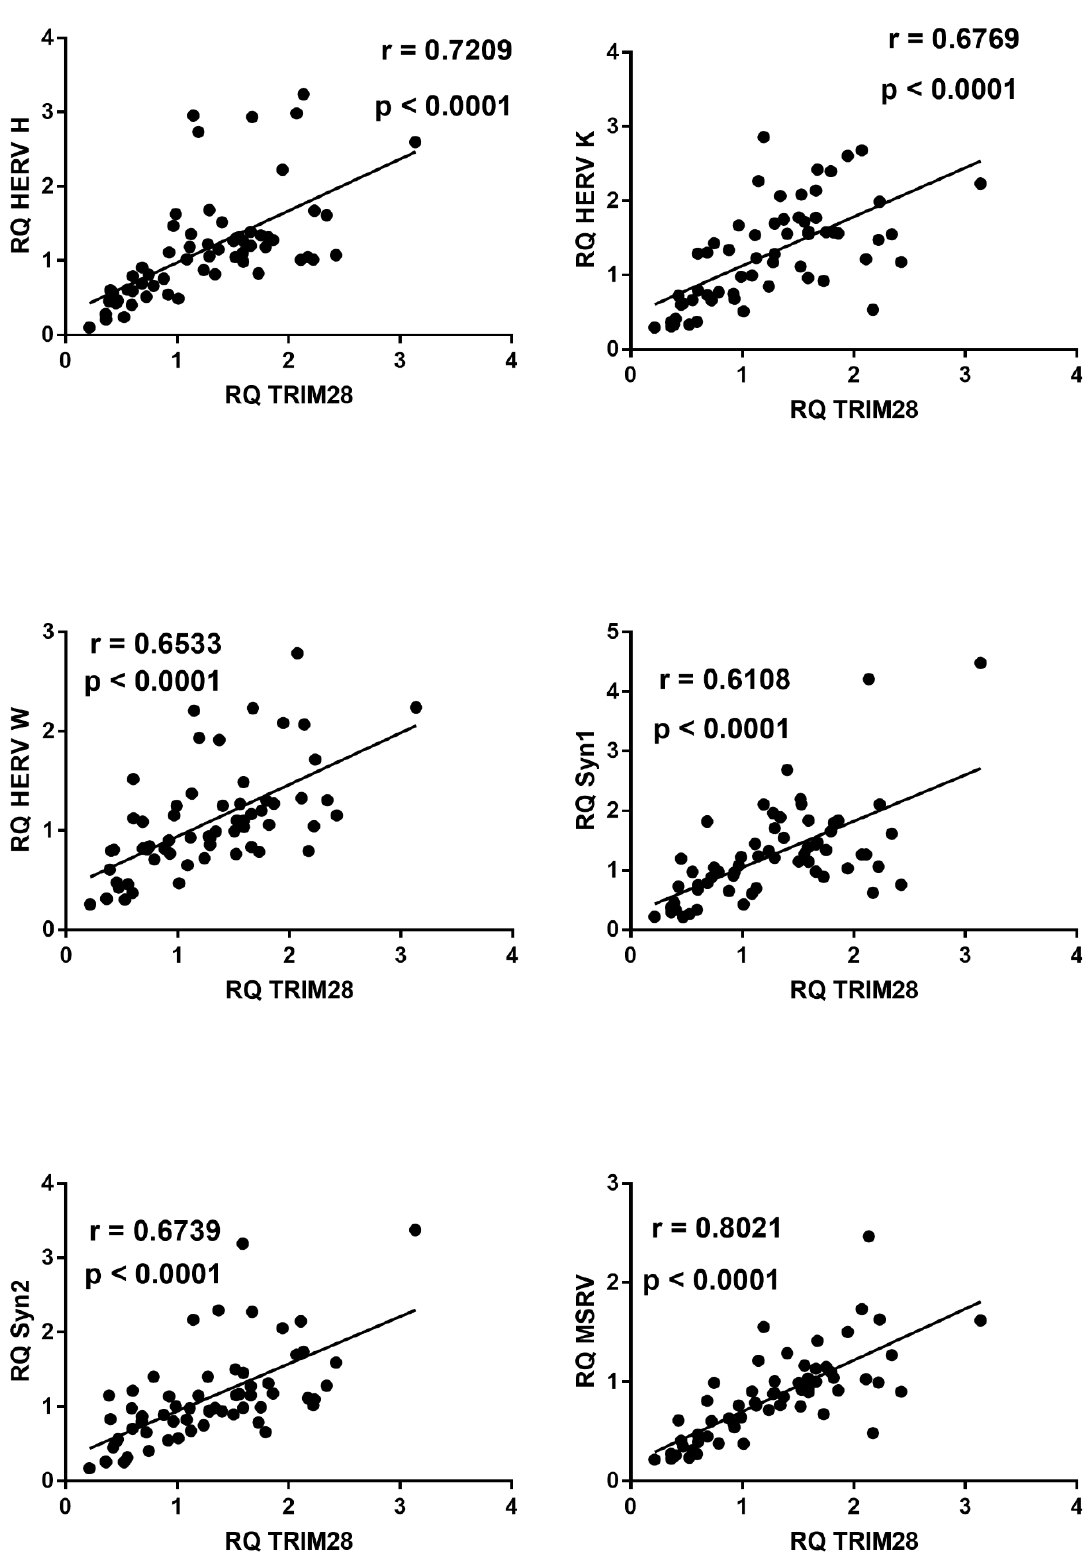
Figure 9. Correlations between transcription levels of TRIM28 and HERV sequences in whole blood from 64 COVID-19-infected children. RQ: relative quantification. Circles show the mean of three individual measurements. Line: linear regression line. Statistical analysis: Spearman correlation test.